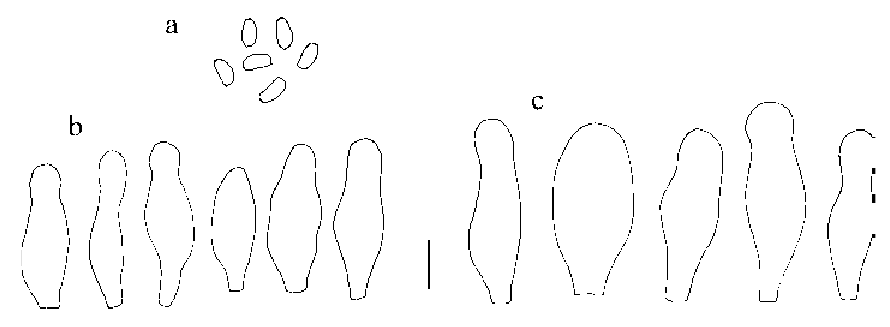
Fig. 5. Psathyrella hydrophiloides kits van Wav., coll. kRAM F-54446; a – spores, b – cheilocystidia, c – pleurocystidia; scale bar = 10